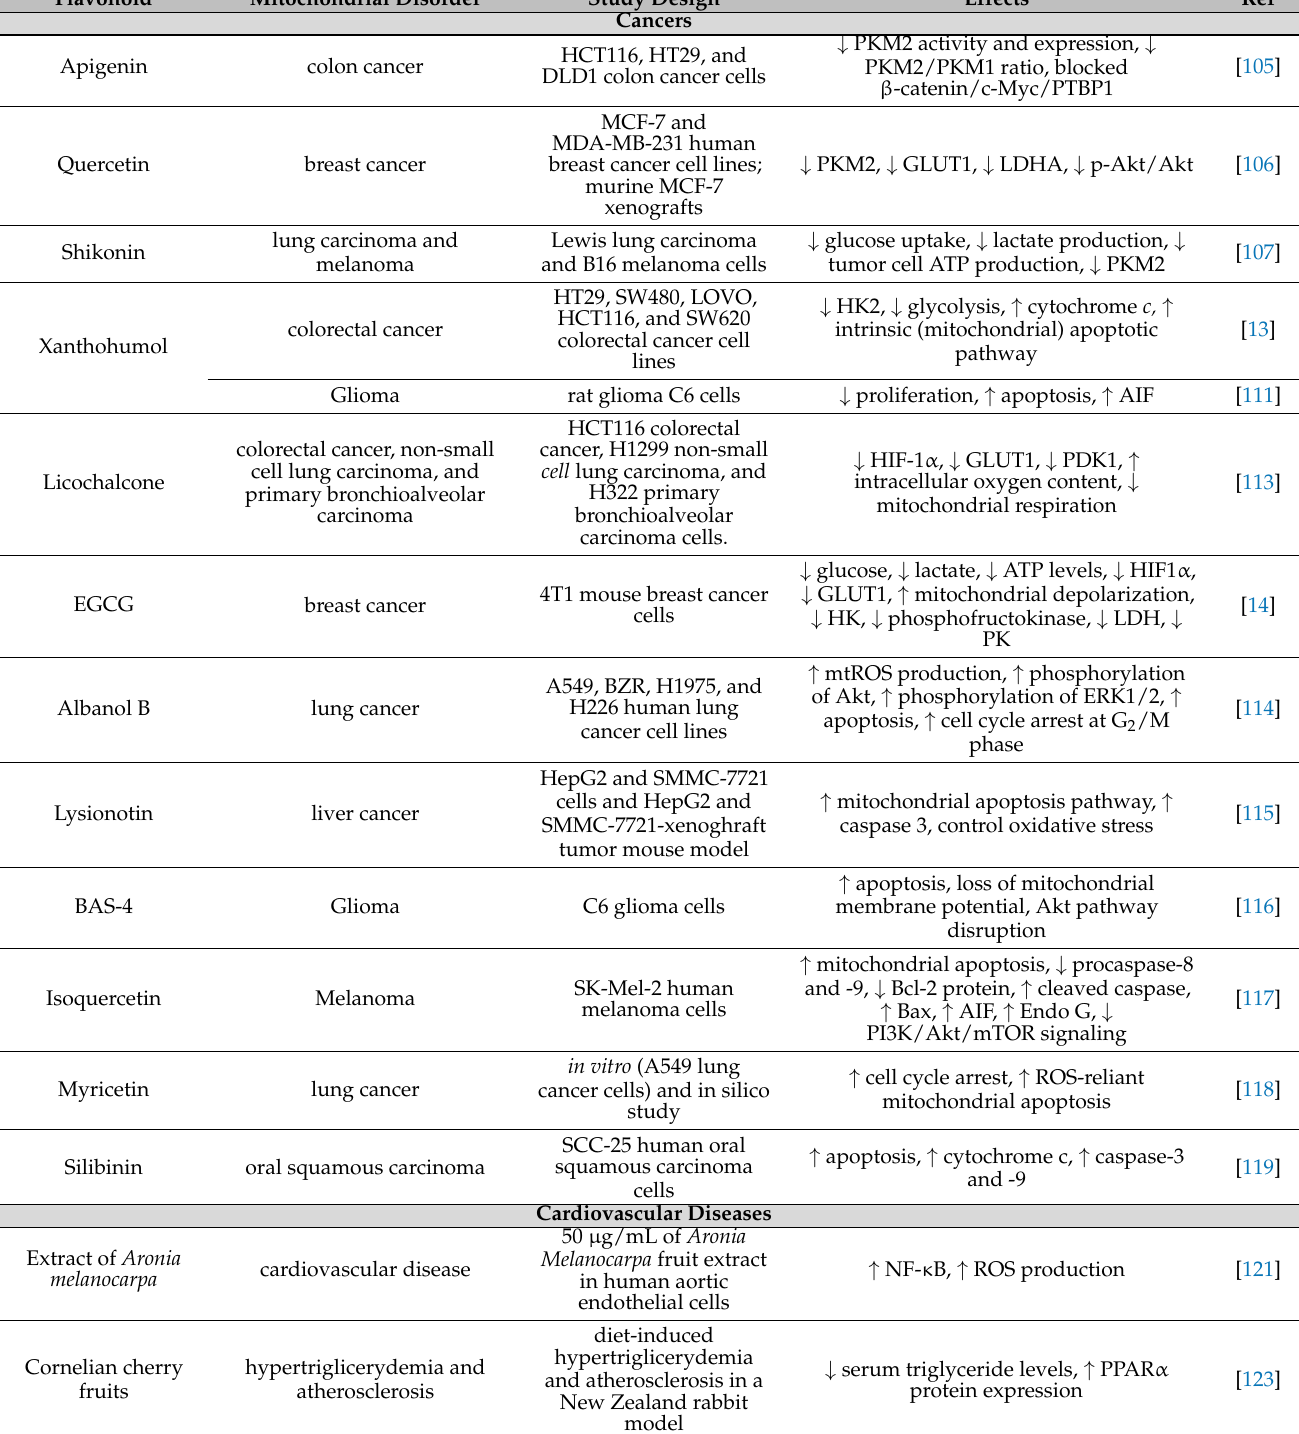
Table 1. Flavonoids targeting deregulated mitochondrial processes associated with cancer, CVDs, and neurodegenerative diseases in preclinical